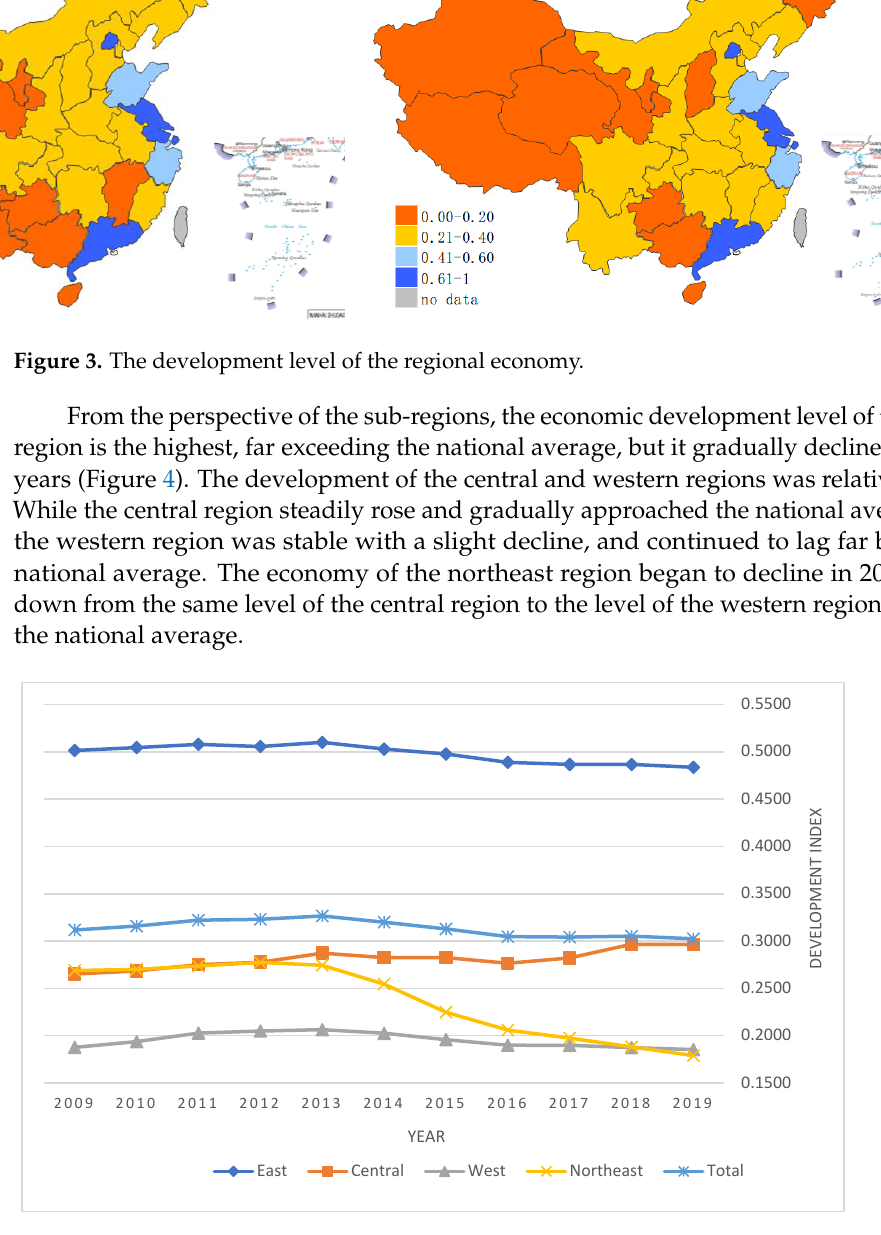
Figure 4. Sub-regional development index of the regional economy